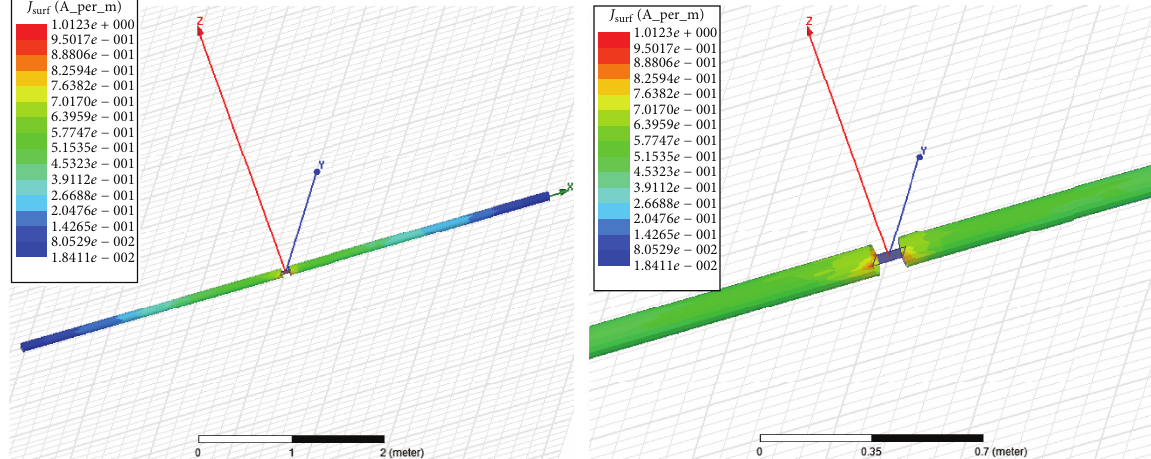
Figure 19: Current distribution on the antenna surface by HFSS.